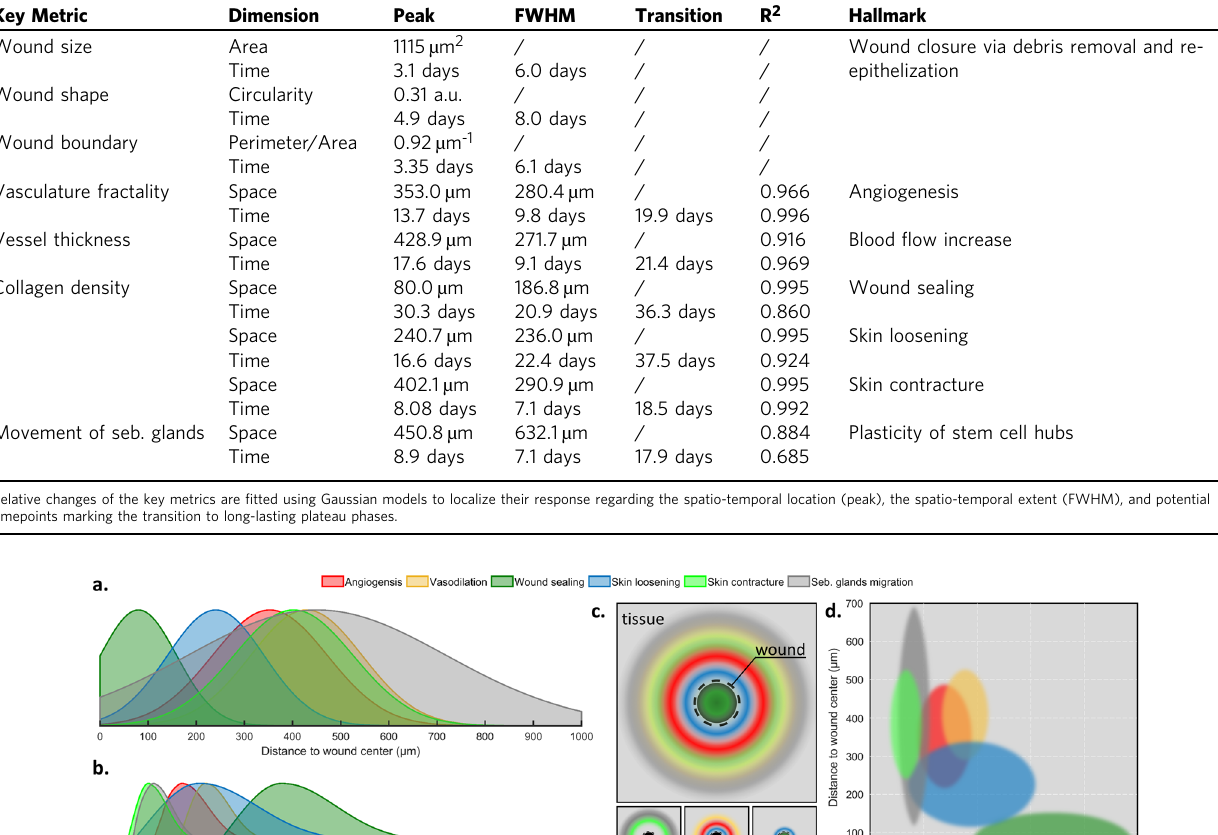
Table 1 Quantitative assessment of the wound healing process via monitoring key metrics in space and time. Key Metric